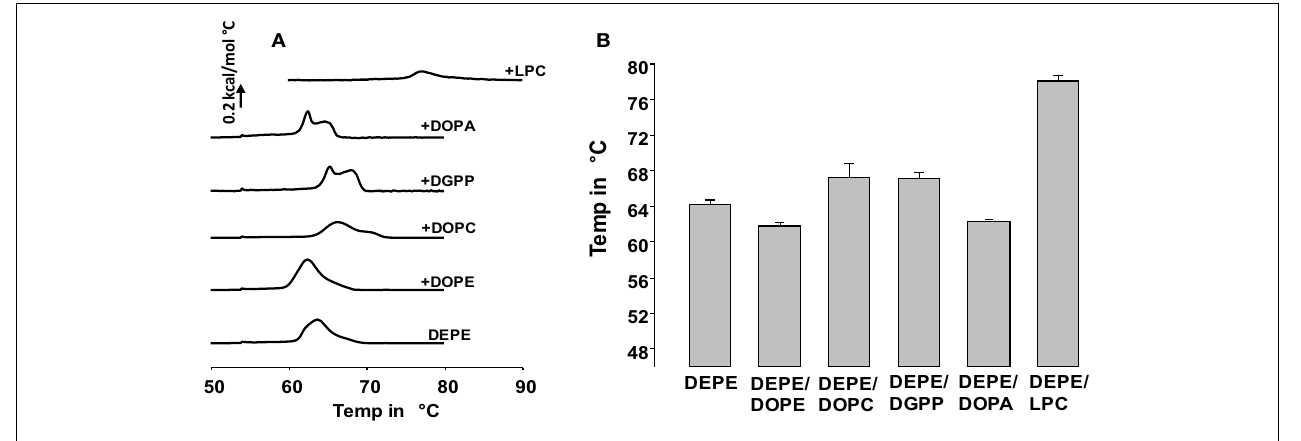
independent experiments. In the case of DOPA, DGPP, and DOPC only the T HII value for the furthest and most prominent peak (up or down from DEPE) is shown.